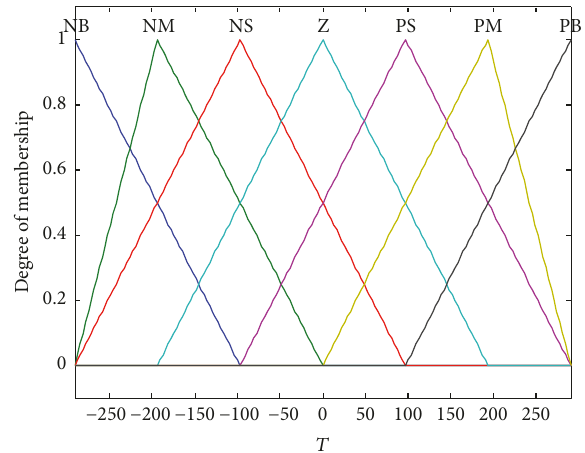
Figure 7: Curve of torque membership function.